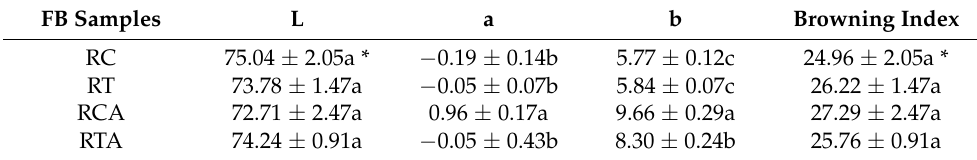
Table 5. Color parameters of FB